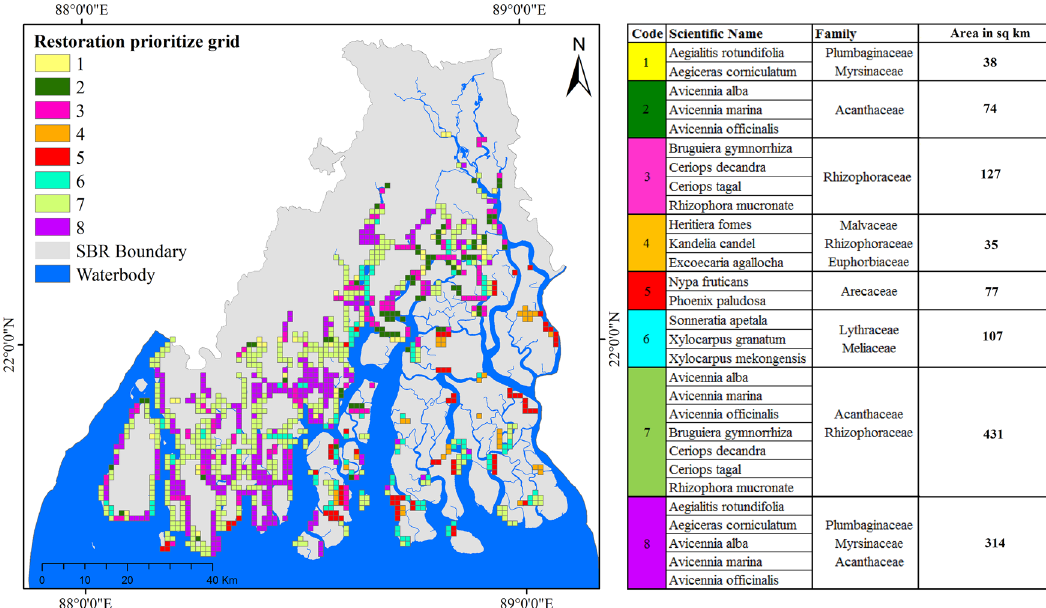
Figure 9. Species wise restoration prioritize grids for 18 selected mangrove species (The map were prepared using ArcGIS 10.8.2 software [https:// deskt op. arcgis.